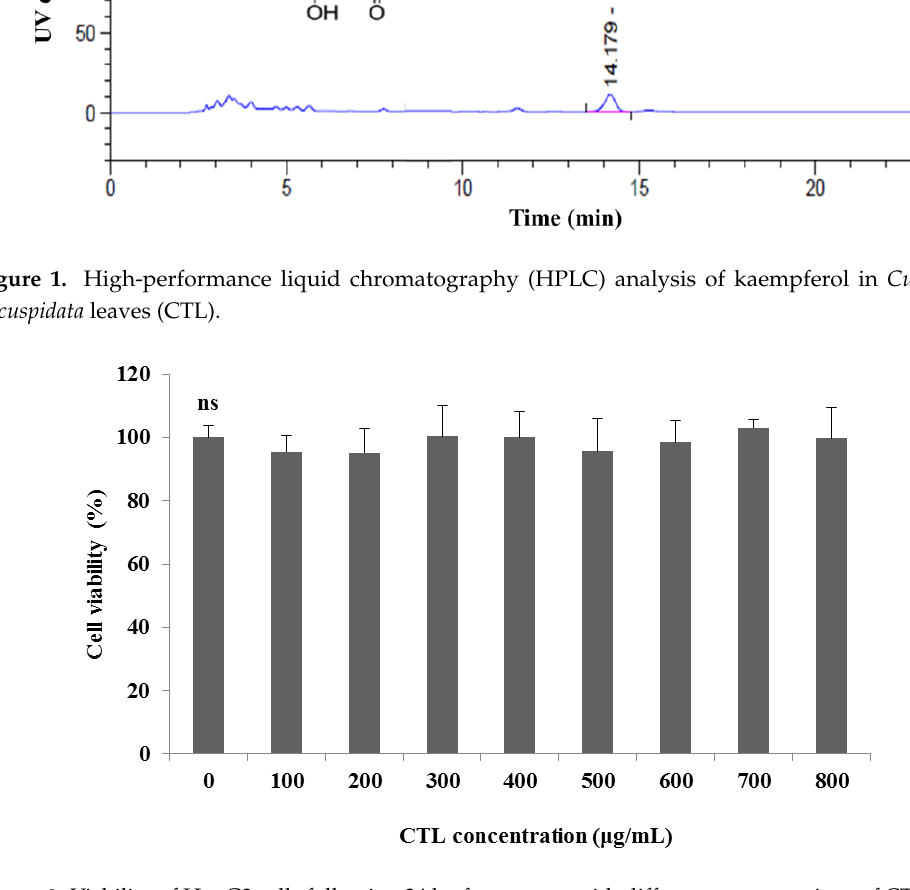
Figure 2. Viability of HepG2 cells following 24 h of treatment with different concentrations of CTL. The data are expressed as the mean ± SD ( n = 3), and significant differences were analyzed using Duncan’s multiple-range test. ns = not significant.